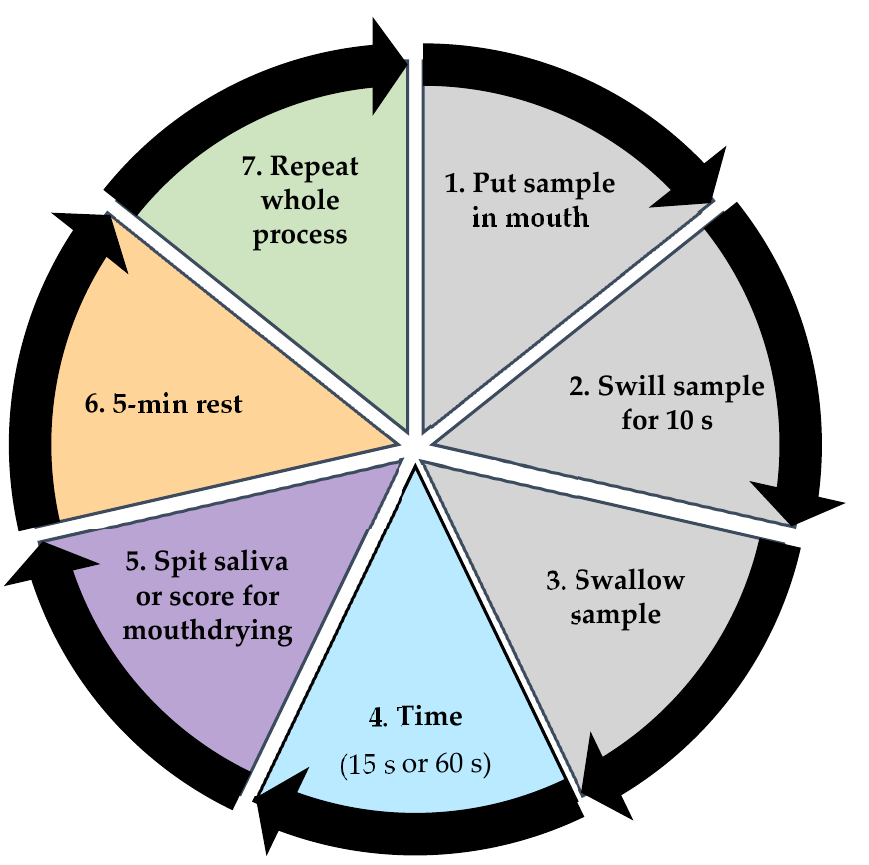
Figure 3. Summary of protocol for saliva sample collection and mouthdrying perception rating post beverage consumption.